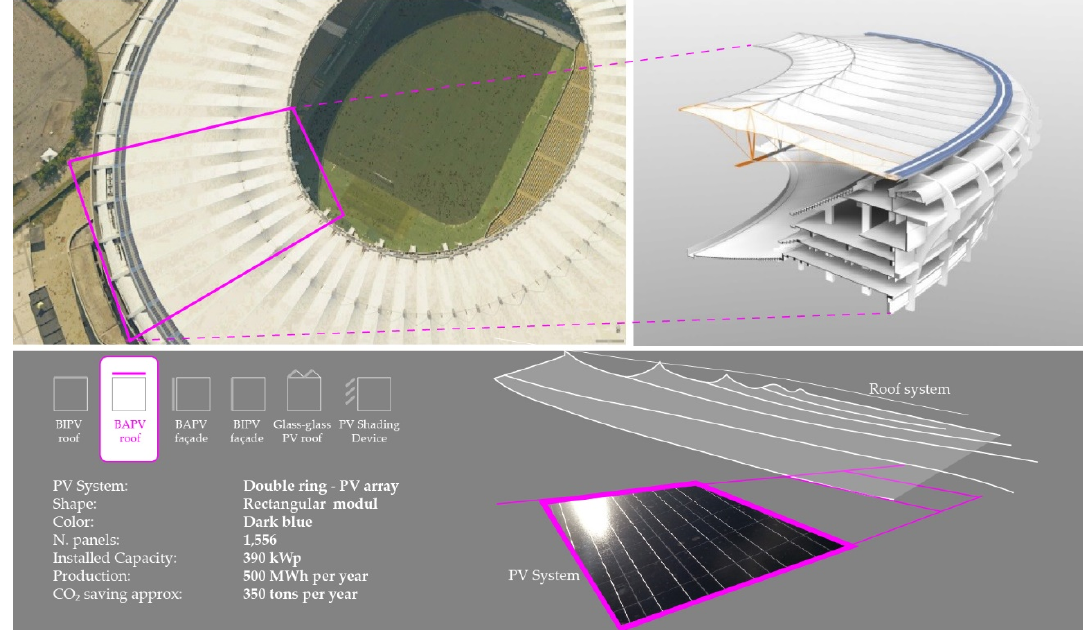
Figure 5. Maracanã Stadium (bird eye view from Google Earth, Google 2020) ( on the top left) ; rendering detail (copyright Schlaich Bergermann Partner) ( on the top right) ; Integration and characteristics of PV systems ( on the bottom ).